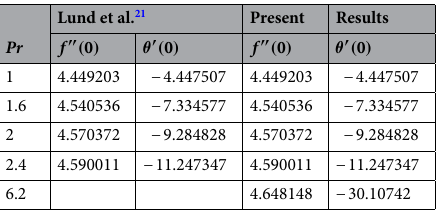
Table 3. Values of f ′′ ( 0 ) and θ ′ ( 0 ) for the various values of Pr by keeping S = 5, φ Al 2 O 3 = φ Cu = 0, (cid:31) 0.5, Rd 0. δ δ T K M 1 = − = = = = =